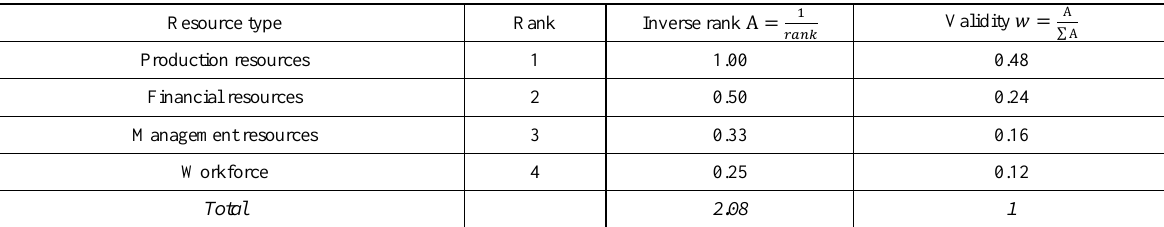
Table 5. Matrix of weight of resources as a part of resource potential